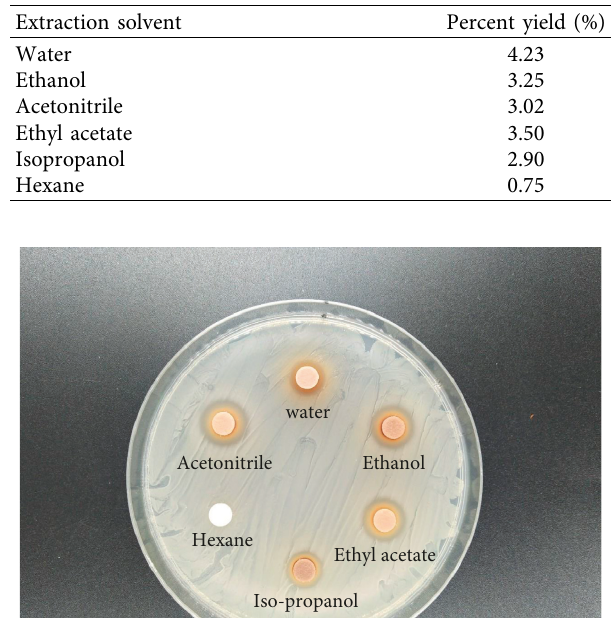
Table 1: Yields of A. lakoocha roxb extracts.